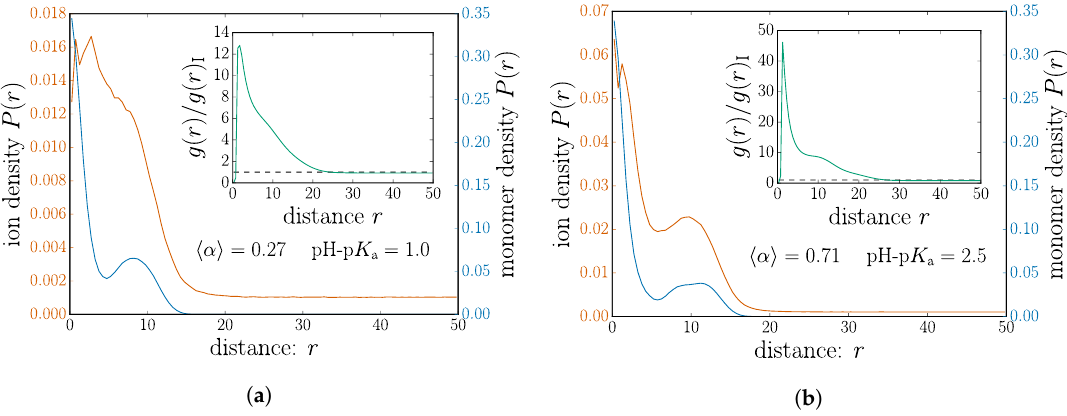
Figure 5. (Color online) The distributions of ions and monomers around the nanogel center of mass. The inset shows the monomer-ion pair correlation function g ( r ) between the monomers and the mobile ions. The two cases are chosen ( a ) above and ( b ) below the Manning parameter. Both subplots have the same salt concentration c s = 0.019